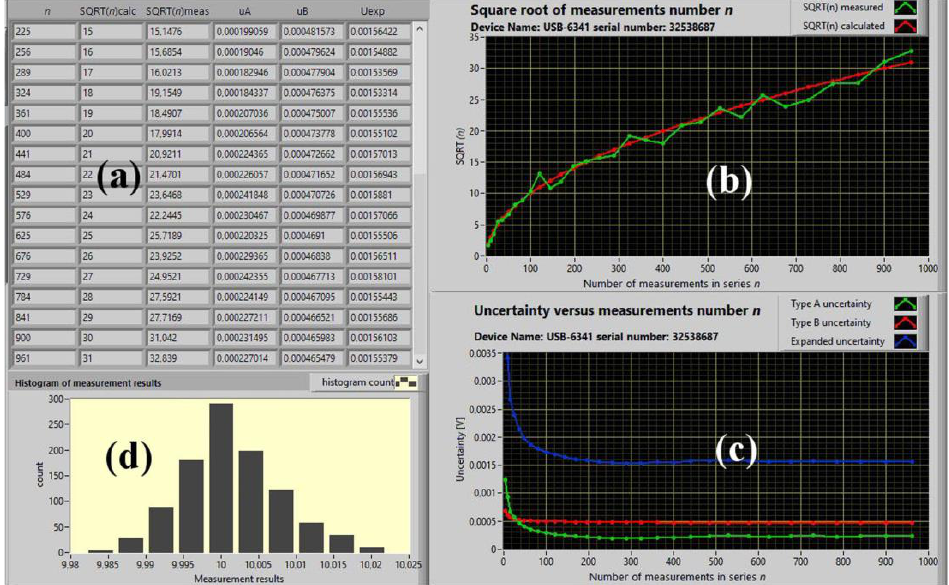
Figure 8. Right panel part of the LabVIEW application: ( a ) results of statistical parameter calculations for repeated multiple measurement series; ( b ) results of the root of the number of measurements and its verification from measurements; ( c ) results of measurement uncertainties type A, type B and expanded uncertainty U; ( d ) histogram of measurement results from a single series.